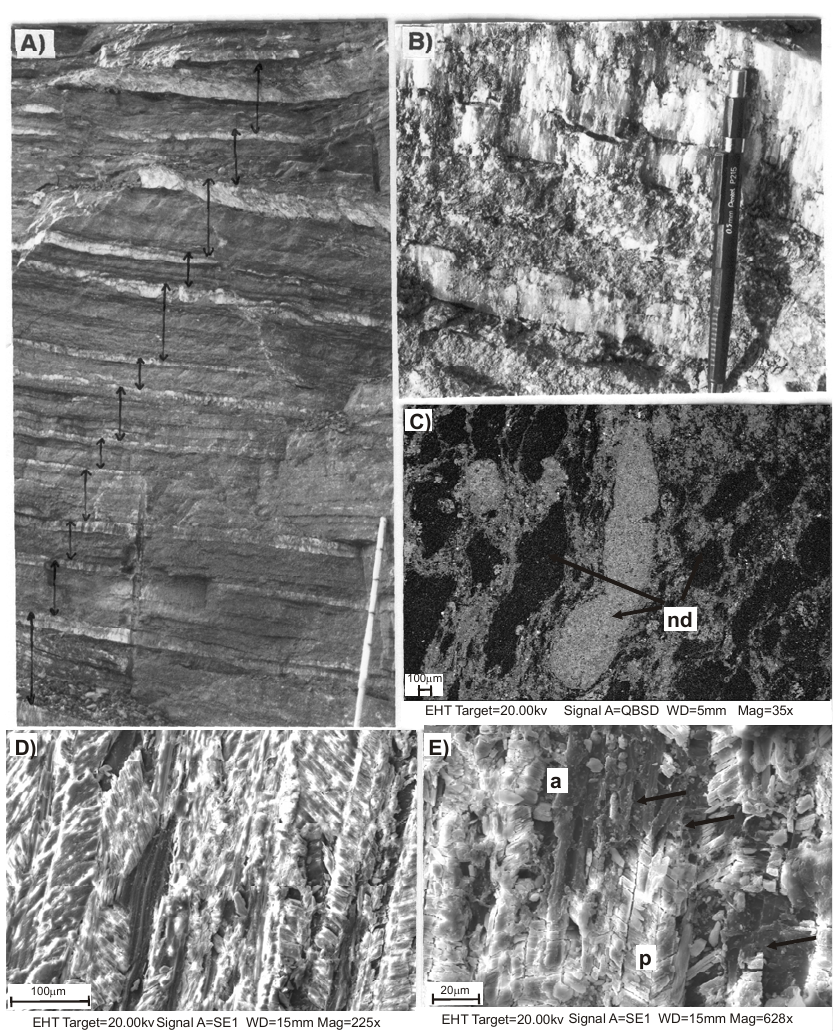
Fig. 3 – Evaporite facies from the Grajaú area, illustrating: A) Laminated gypsum (facies Gl) formed by successive alternating darker andlightercouplets, consistingofmicronodularandpalmate/aciculargypsum, respectively. Notepackagesofcouplets(arrows)defined by thicker lighter beds, which become progressively thicker upward. (sub-division in the rod for scale = 10 cm). B) A detail of a darker/lighter couplet shown in figureA. (pen for scale = 15 cm long). C-D) Electron microscope photographs showing micronodular gypsum (nd) from a darker part of a couplet (C), palmate gypsum from a lighter bundle of a couplet characterized by growth-aligned crystals with twin planes (D), and palmate gypsum (p) being replaced by acicular (a) gypsum (E). Note in the later the presence of ghosts of the palmate gypsum (arrows) within the acicular